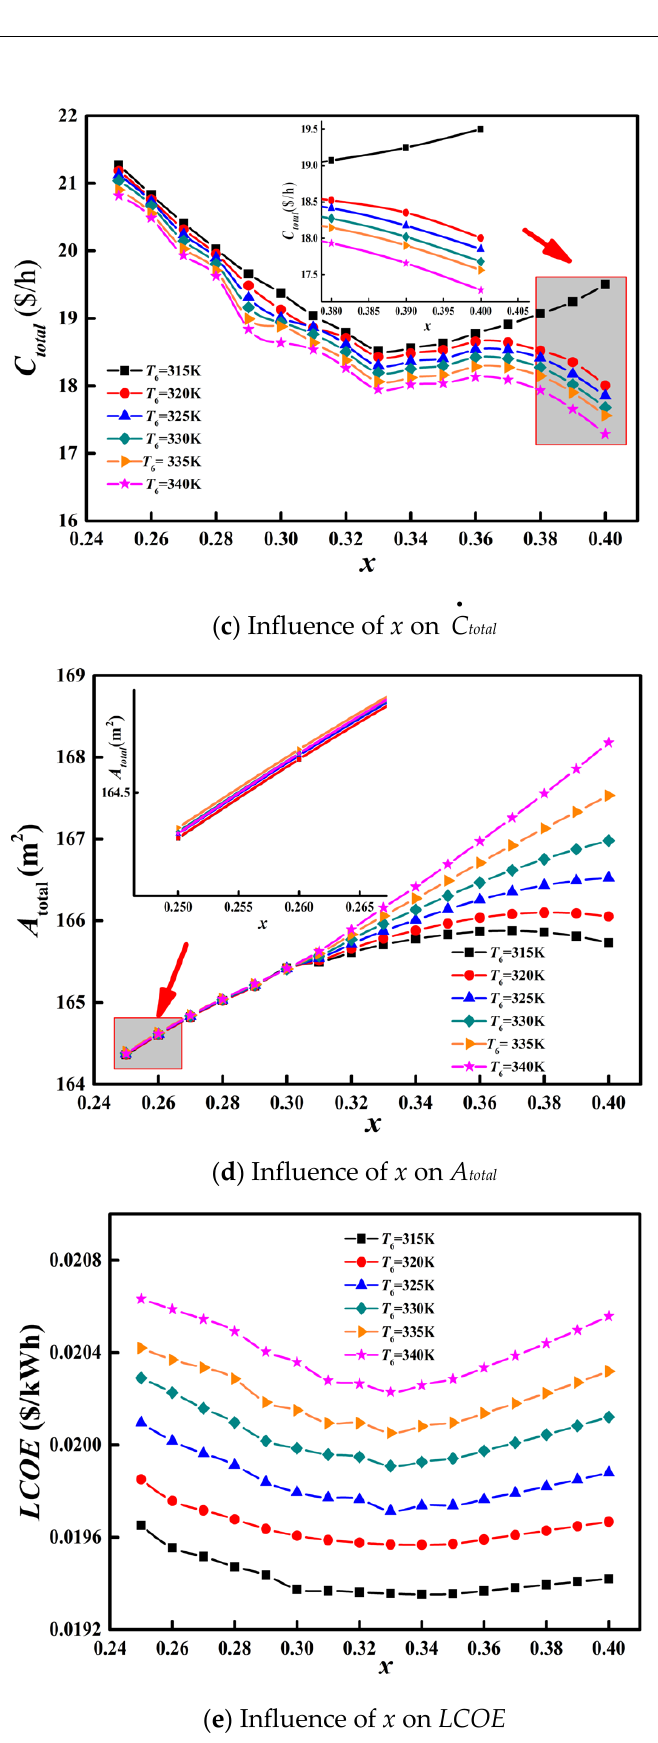
Figure 6. Influence of x on the proposed S-(N 2 O-He) cycle.